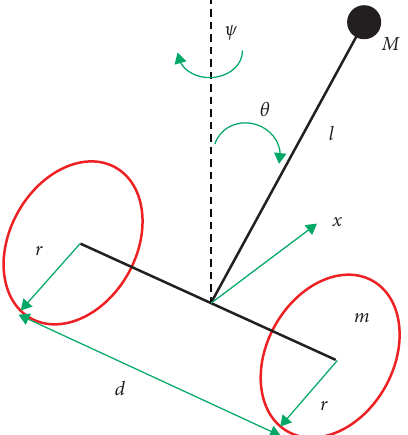
Figure 1: Schematic diagram of a